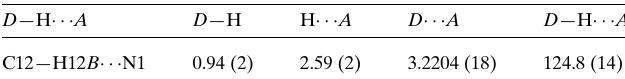
Table 1 Hydrogen-bond geometry (A˚ , (cid:4)